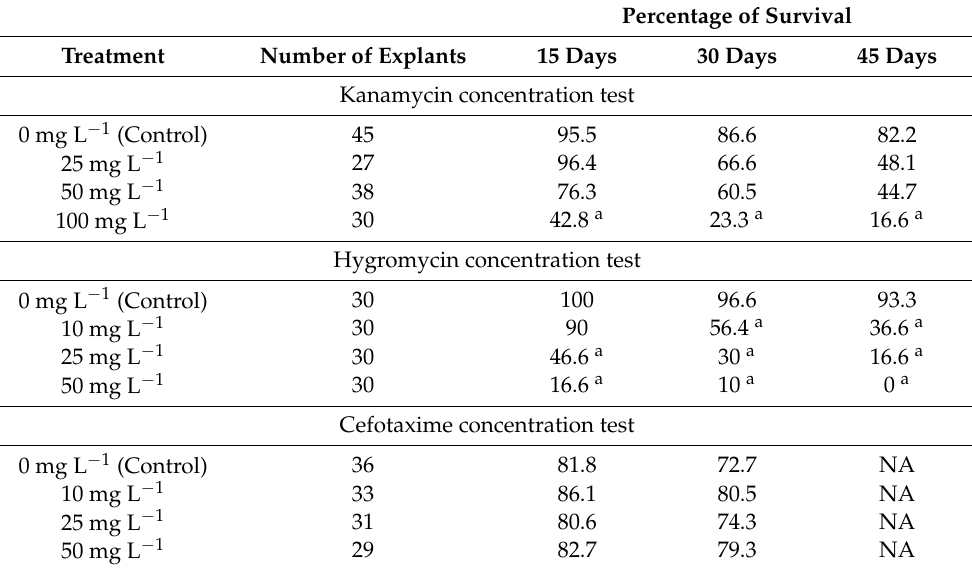
Table 1. Summary of the antibiotic sensitivity tests conducted with different concentrations. a Significant at the 1% level between treatments and control (proportion test).